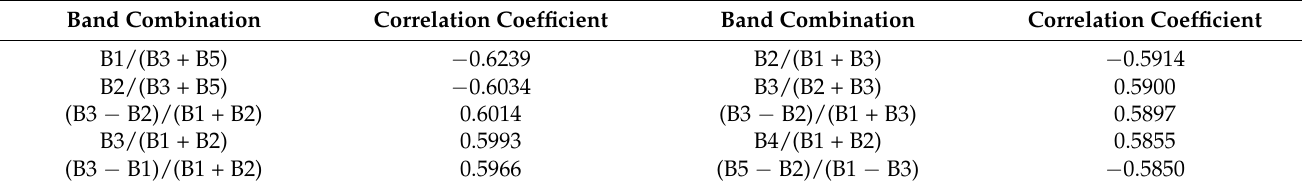
Table 1. Correlation coefficients of multi-band combinations with Chla concentration.